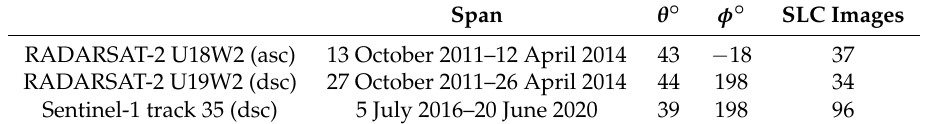
Table 1. RADARSAT-2 and Sentinel-1 SAR data used in this study, where θ is incidence and φ is azimuth angles. Span θ ◦ φ ◦ SLC Images